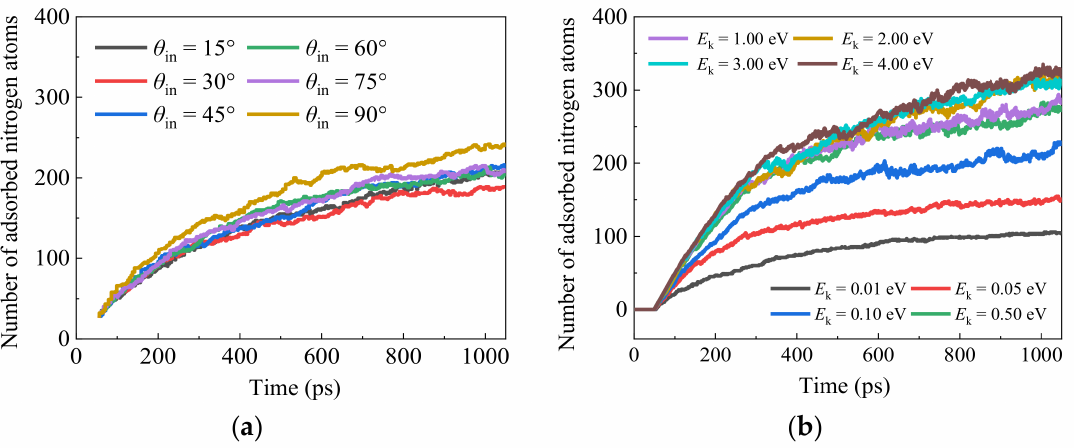
Figure 12. Adsorption of nitrogen atoms on the silica surface with variations in time for the case with the incoming AN gas. ( a ) The effect of incident angle on the surface adsorption by Models IV-21–26, and ( b ) the effect of incident translational energy on the surface by Models